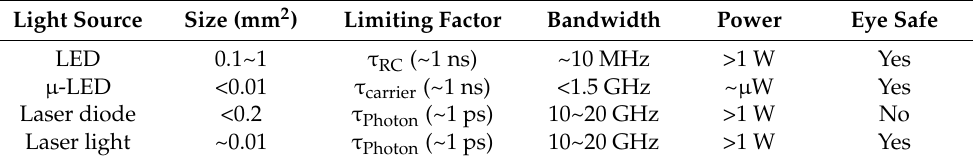
Table 1. Comparison of light source used in the VLC